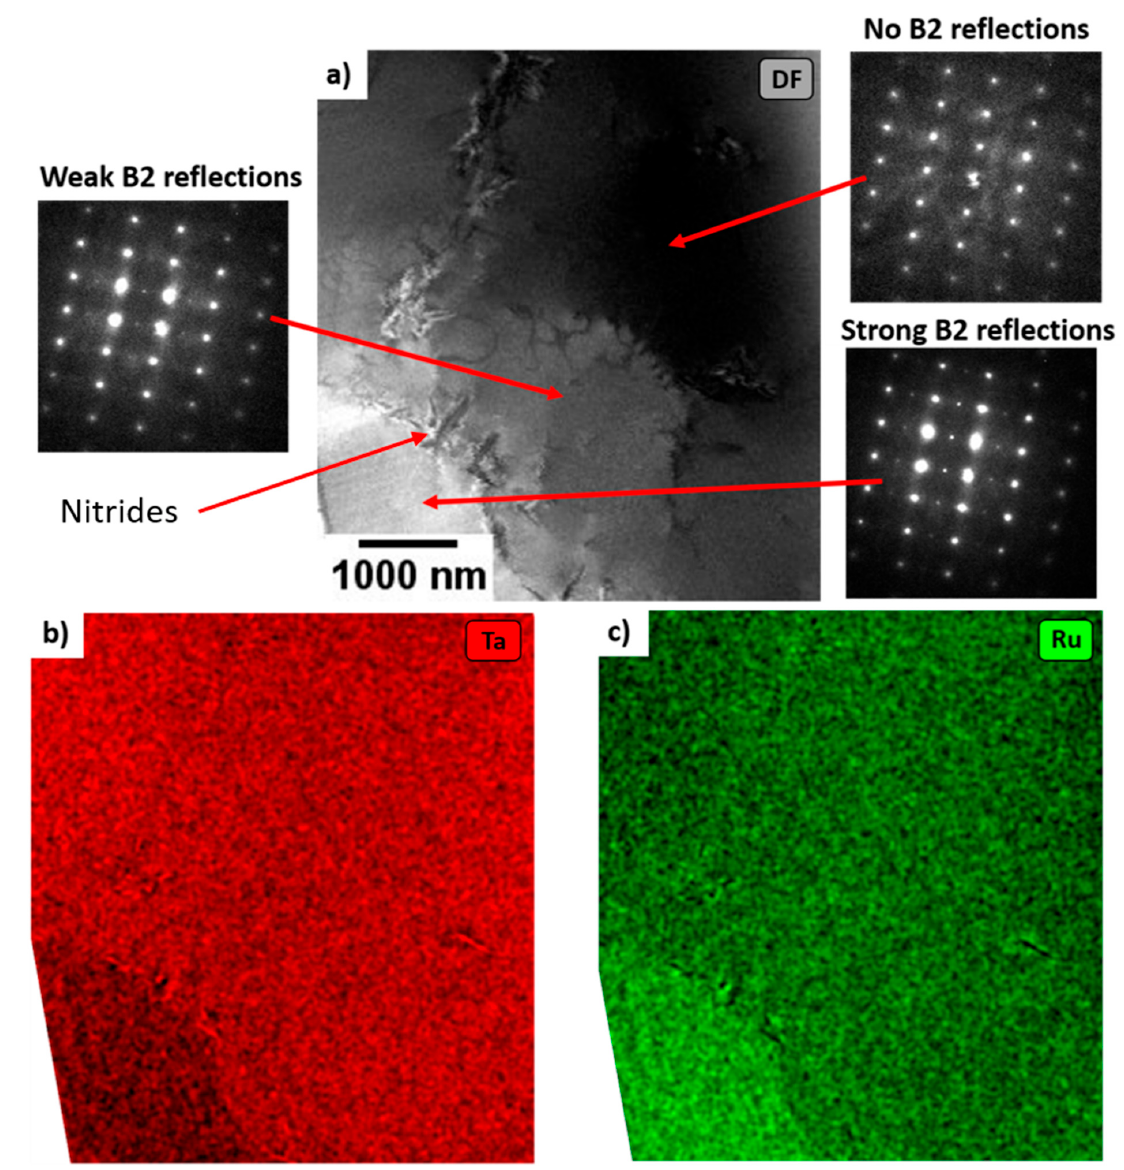
Figure 3. STEM analysis of the as cast material. ( a ) Dark field composed using (100) B2 type reflections, viewed down the [011] zone axis and ( b – c ) EDX elemental maps showing a Ru enriched region at the bottom left and small Ru fluctuations across the rest of the foil (a Ru-poor region). Strong B2 reflections can be seen in the Ru enriched region, and weaker B2 reflections can still be seen in the matrix where the Ru content is slightly higher than other areas.